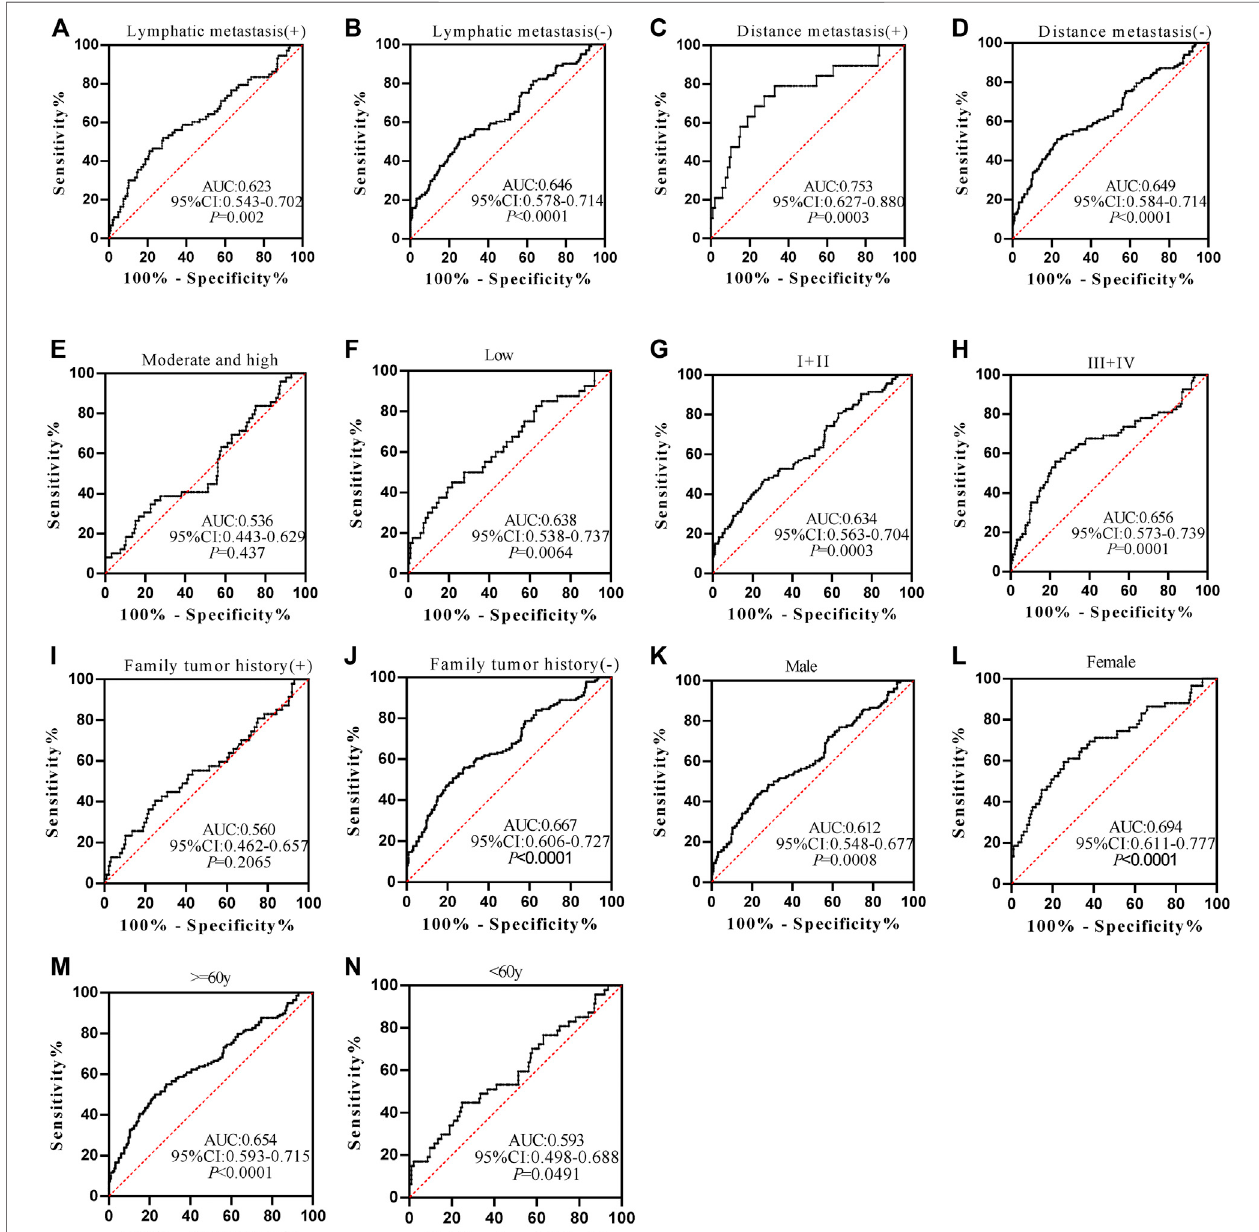
FIGURE 5 | The performance of anti-POSTN autoantibody in ESCC patients with different clinical characteristics.